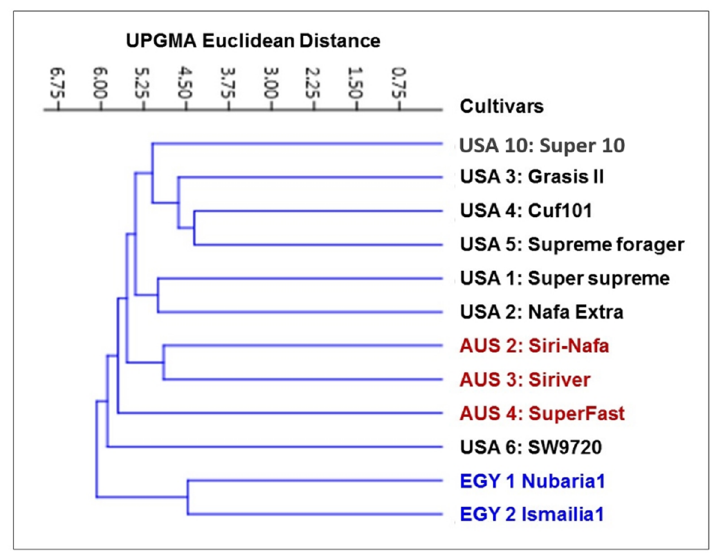
Figure 1. Agarose gel electrophoresis of PCR amplicons of some representative IRAP primers showing polymorphism of IRAP markers. DNA size marker Gene-Ruler 1 Kb plus DNA ladder (lane M) was used as molecular size standards in bps. Numbers from 1 to 12 refer to the sampling numbers of studied cultivars.